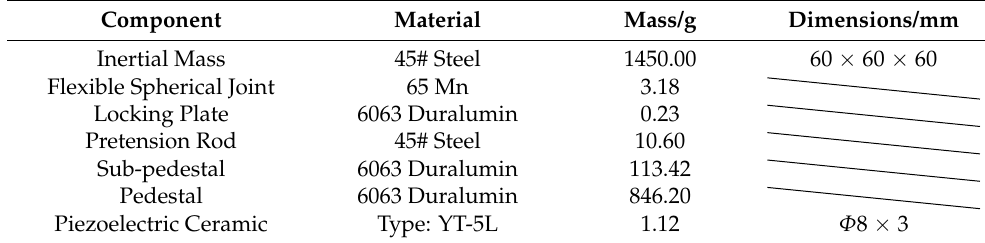
Table 2. Main physical parameters of the physical prototyping.